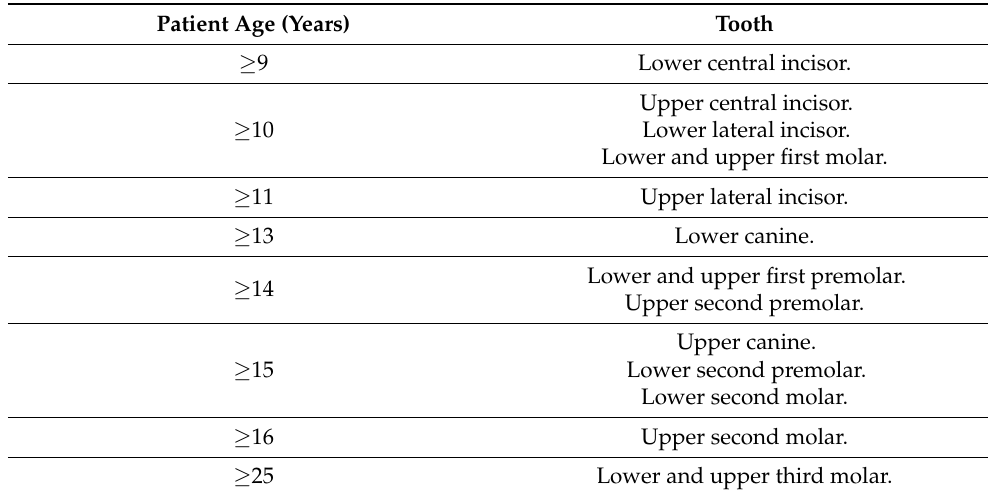
Table 2. The study population included patients who received a REP in the corresponding tooth when aged equal or higher, as it is shown in the table [31].